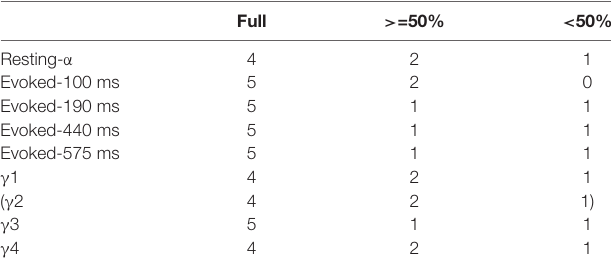
The table indicates number of individual patients who exhibited a given effect observed at the group level. Full: for all significant regions, the corresponding effects were observable at the individual level. > =50%: effects corresponding to at least half of the significant observableattheindividuallevel.Incaseofanoddnumberofregions,50%wasobtained by rounding up the numerical half. < 50%: less than half (including none) of the regions. For example, there are two regions (anterior and occipital) in the case of resting α -power. Note that γ 2 (in parentheses) was not further considered (see text for